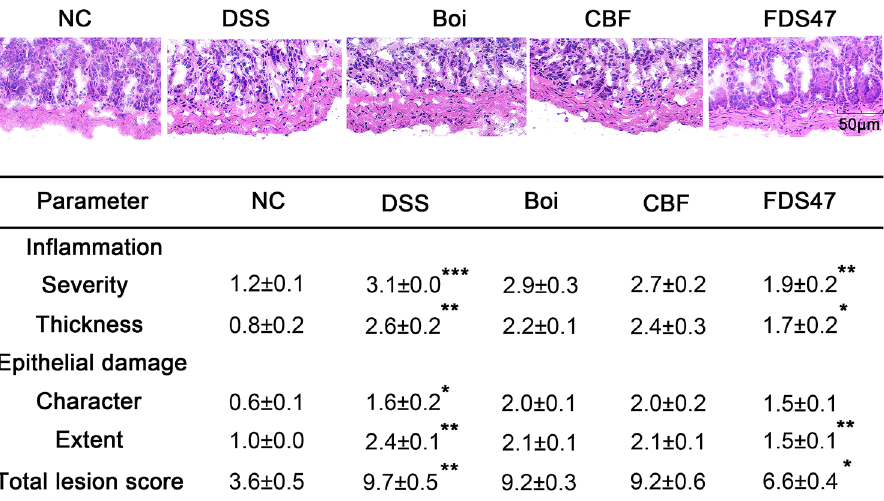
Figure 5. Histological sections of colonic tissue stained with hematoxylin and eosin. ( A ) Histological sections of colonic tissue stained with hematoxylin and eosin (HE) under microscope. Boi (boiled), CBF (compound bacterium fluid) and FDS47 (fermented Danshen sequence 47). ( B ) Effects of DSS on colon pathology of DSS- induced UC mice. DSS group was compared with NC group. FDS47 group was compared with DSS group. (Data are expressed as means ± S.E. * p < 0.05, ** p < 0.01 and *** p < 0.001).